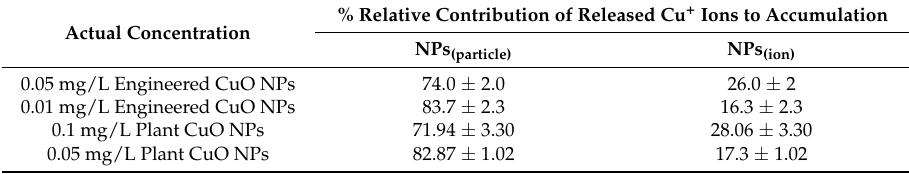
Table 3. Relative contribution of nanoparticles and released ions to accumulation in Daphnia